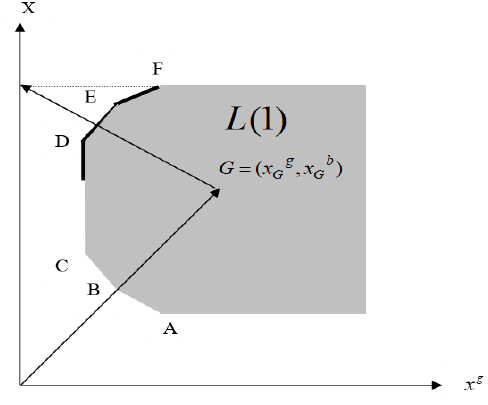
Fig. 1. The graph of the L (yG)